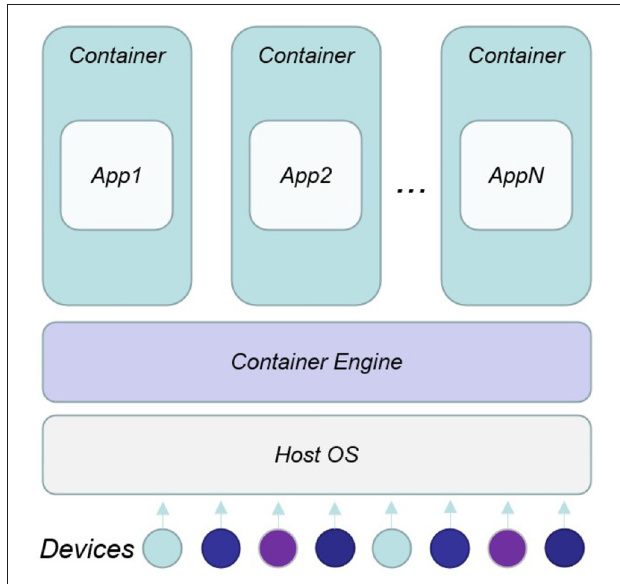
FIGURE 3 | Architecture of containerized gateway.